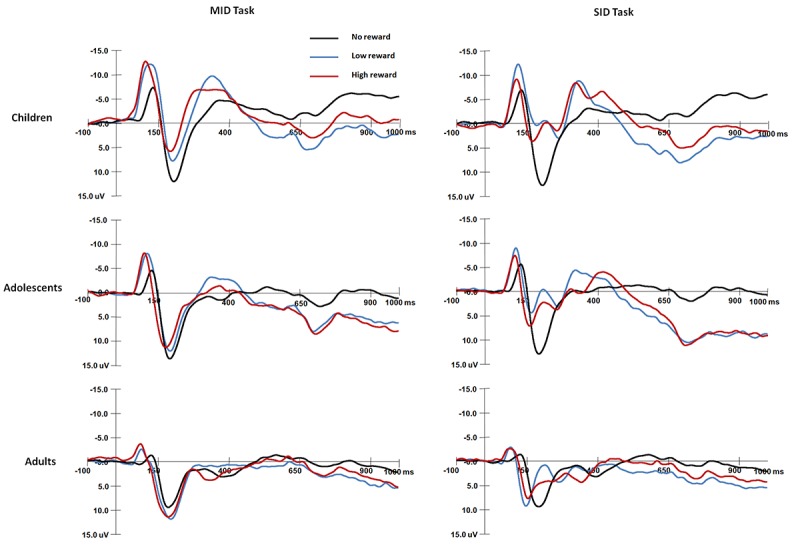
Grand average waveforms of FRN components over fronto-central areas (FCz) in response to the presentation of the feedback stimuli for each age group.